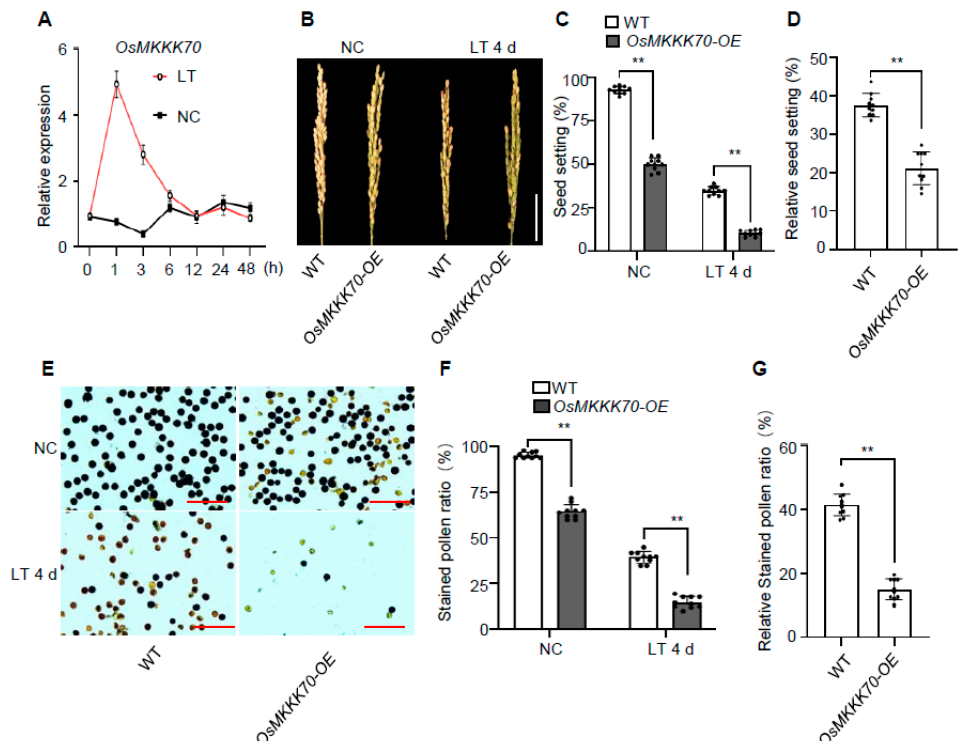
Figure 1. OsMKKK70 is involved in cold tolerance at the booting stage in rice. ( A ) Time course of OsMKKK70 relative expression in panicles of WT exposed to a 15 °C cold treatment during the booting stage. The expression level on 0 h was set to 1. Data are shown as means ± SE (n = 3). ( B – D ) Representative images of panicles ( B ), seed setting rate ( C ), and relative seed setting rate ( D ) of WT and OsMKKK70-OE plants grown under NC, and after LT treatment for 4 days. The scale bar in ( B ) is 5 cm. Data are shown as means ± SE (n = 10). ( E ) Representative images of stained pollen from WT and OsMKKK70-OE plants grown under NC, and after LT treatment for 4 days. The scale bars are 50 μ m. ( F ) Quantification of stained pollen ratio in ( E ). Data are shown as means ± SE (n = 10). ( G ) Quantification of relative stained pollen ratio in ( E ). Data are shown as means ± SE (n = 10). Each dot represents the result from one biological replicate, and error bars indicate means ± SE. p values were calculated by Student’s t -test; ** p < 0.01.